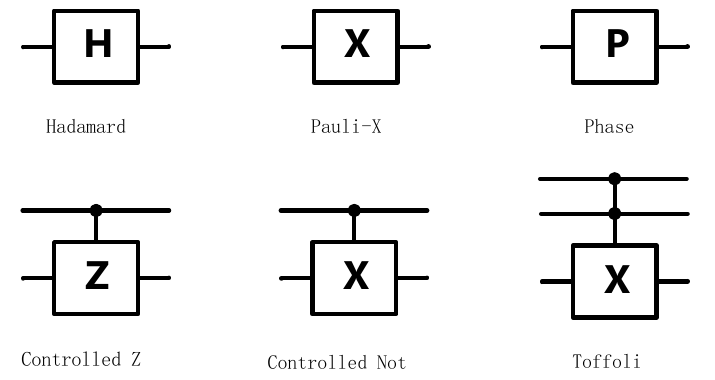
Figure 2. Partial quantum gate.